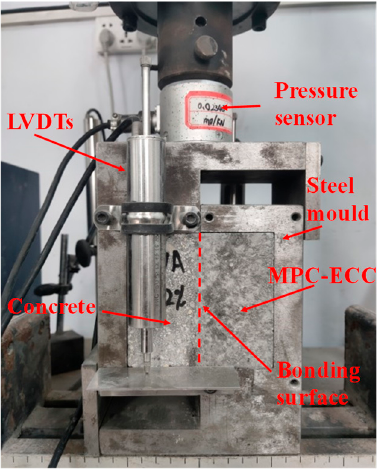
Figure 3. Setup of the single shear bond strength test.